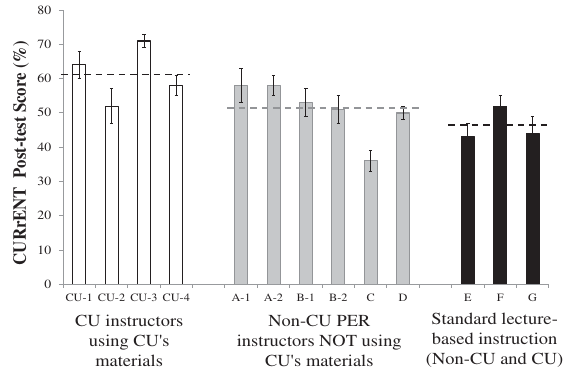
FIG. 5. Histogram of average course score on the CURrENT across 6 institutions demonstrating preliminary indications of improved performance for CU ’ s transformed ( N ¼ 124 ) and PER ( N ¼ 172 ) courses relative to courses using only traditional lecture ( N ¼ 50 ). Overall averages by course are marked by the dashed